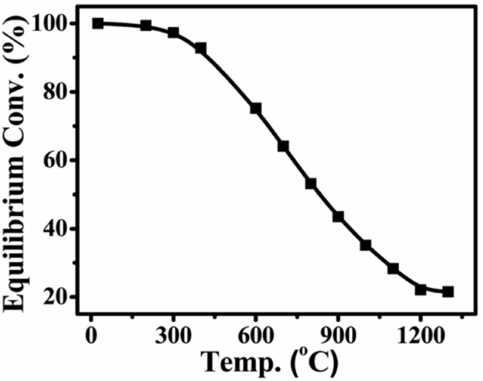
Figure 9. A plot of equilibrium CO 2 conversion in methanation at various temperatures (based on literature data)